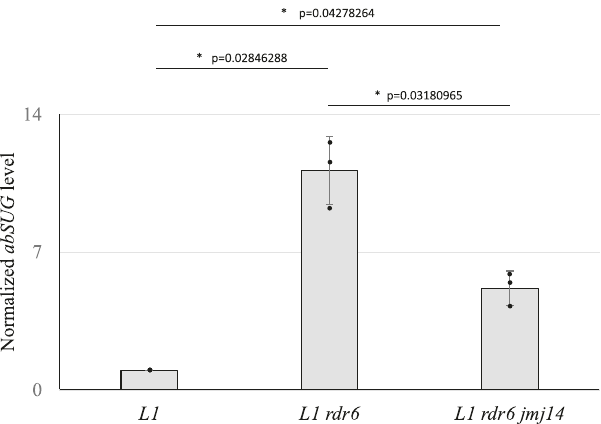
Fig. 3 Impairing JMJ14 decreases the steady state level of aberrant abSUG RNA. Normalized expression of abSUG RNA in L1, L1 rdr6 and L1 rdr6 jmj14 plants. Results are expressed as a fold change compared to L1 ( L1 = 1) and normalized to eIF1a . Error bars represent the standard deviation of three replicates. The signi fi cance was assayed with a Bonferroni corrected t -test ( P <